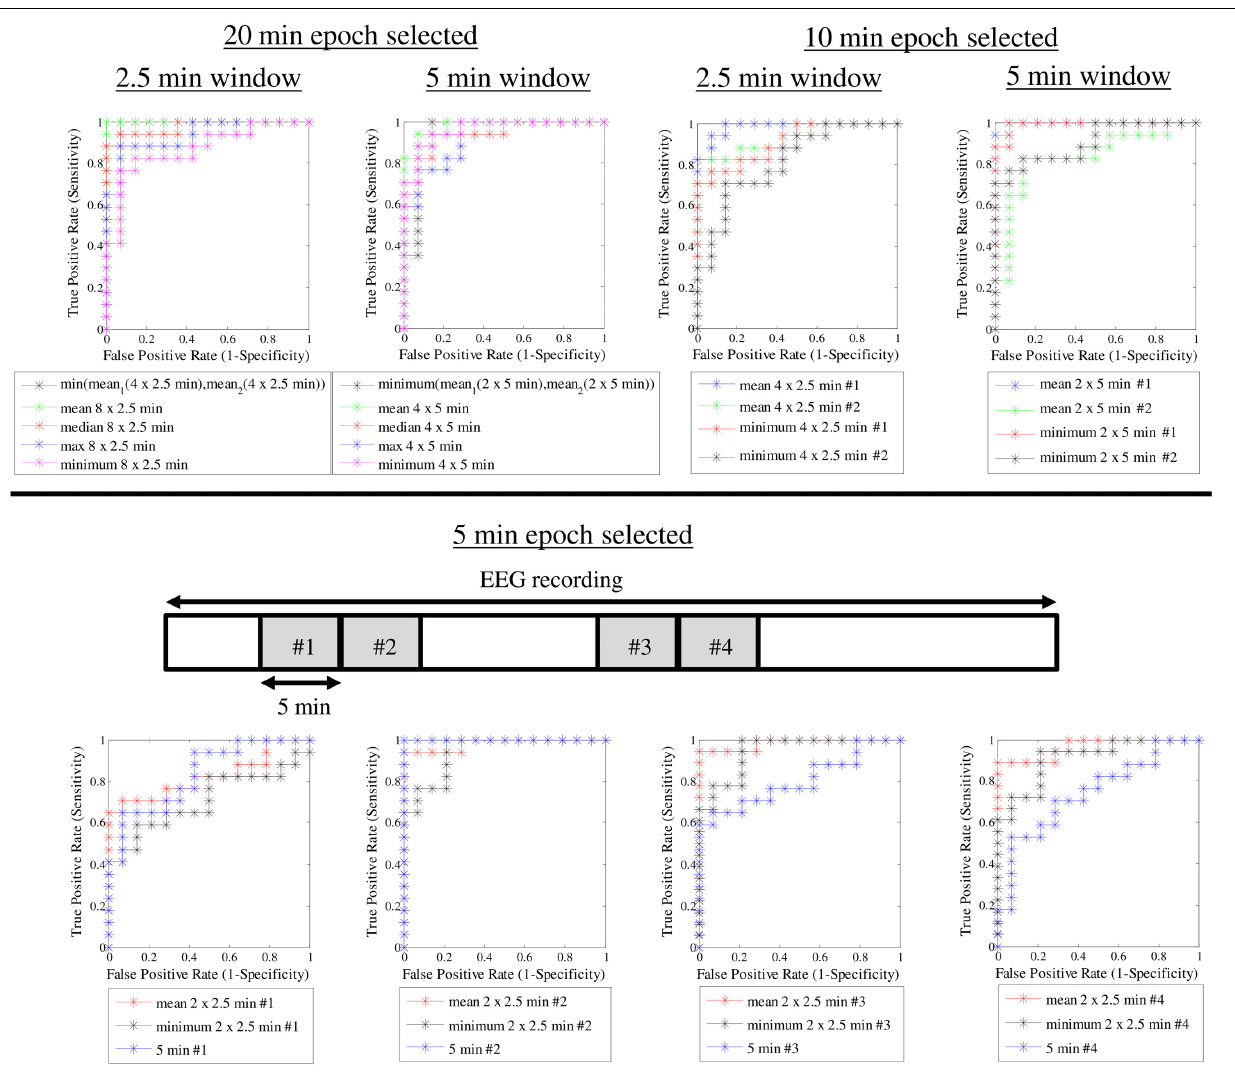
FIGURE 5 | ROC curves for different ASI window lengths and different epoch